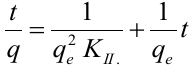
values obtained eq